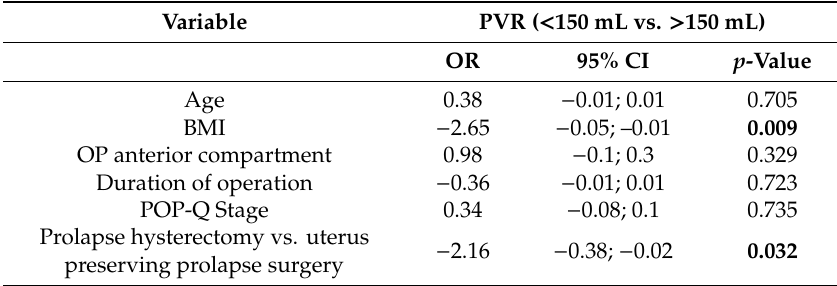
Table 3. Multivariate regression analysis with PVR as dependent variable and clinical characteristics as independent